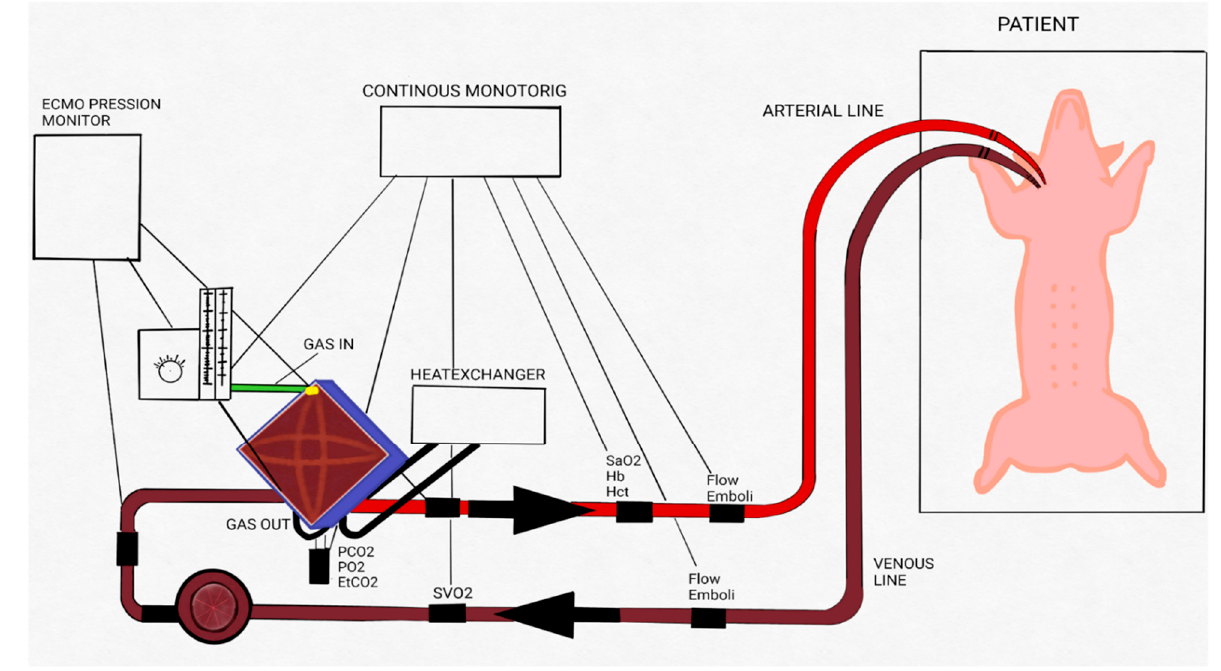
Figure 1. Extracorporeal membrane oxygenation (ECMO) circuit scheme. Schematic drawing of the ECMO circuit used for animal experiments. Adapted with permission from Ref. [26]. Copyright 2018, copyright owner’s Raffaeli G et al. [26]”.